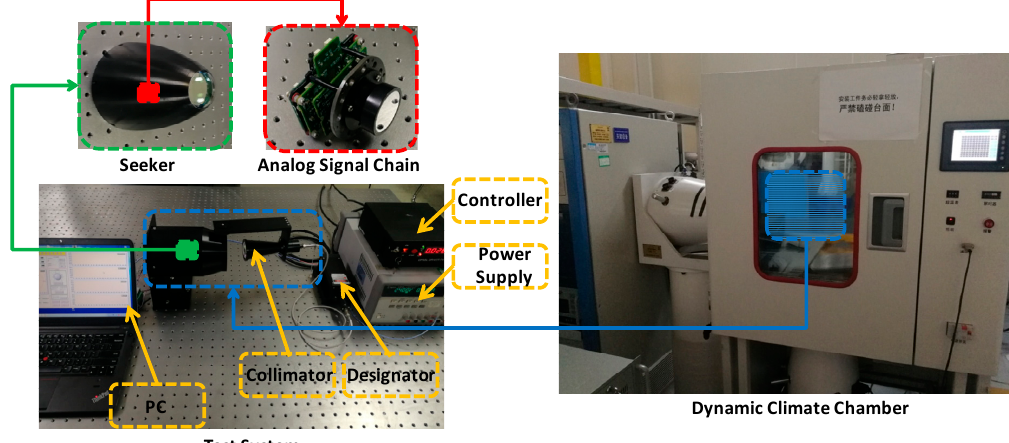
Figure 11. The test system and dynamic climate chamber.